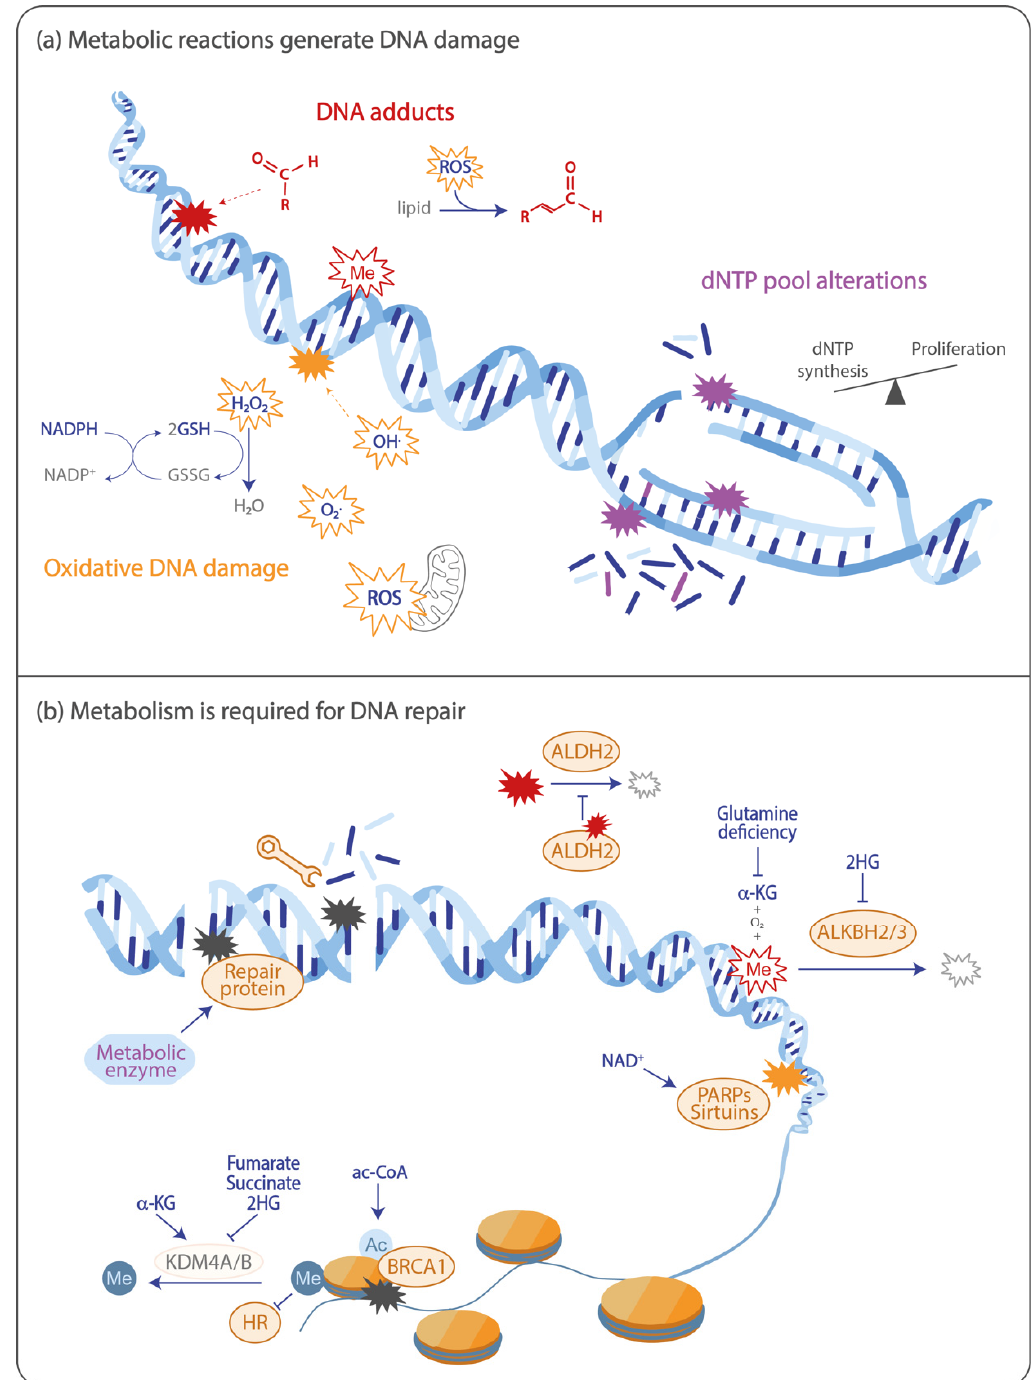
Figure 1. Interplay between cellular metabolism and the DNA damage response in cancer. ( a ) Metabolic reactions generate DNA damage. Toxic metabolites, such as alkylating agents and aldehydes, which are produced by lipid peroxidation and other metabolic pathways, can generate DNA adducts. Reactive oxygen species (ROS), mainly produced by oxidative phosphorylation, generate oxidative DNA damage. ROS can be detoxified by antioxidants, such as glutathione (GSH) and nicotinamide adenine dinucleotide phosphate (NADPH). The increased proliferation of cancer cells (as depicted in the top strand) can deplete dNTP pools causing replication stress and, consequently, DNA double-strand breaks (DSBs). Imbalances in nucleotide pools (as depicted in the bottom strand) cause misincorporations during replication, which can lead to mutations. ( b ) Metabolism is required for DNA repair. Metabolic enzymes recruit DNA repair proteins to the sites of DSBs, and the production of a local pool of nucleotides in the vicinity of DSBs is needed for accurate